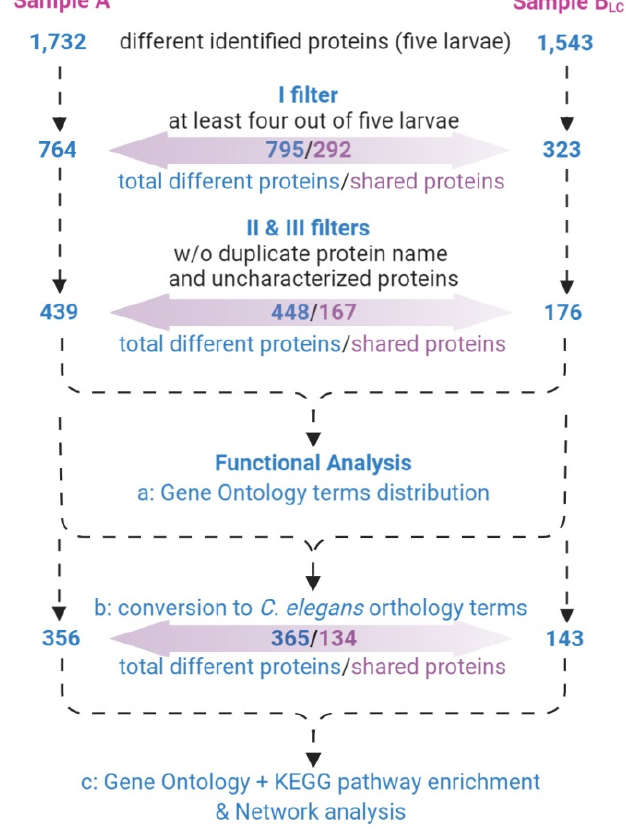
Figure 6. Filters applied to protein lists prior to performing functional bioinformatic analyses. KEGG, Kyoto Encyclopedia of Genes and Genomes.